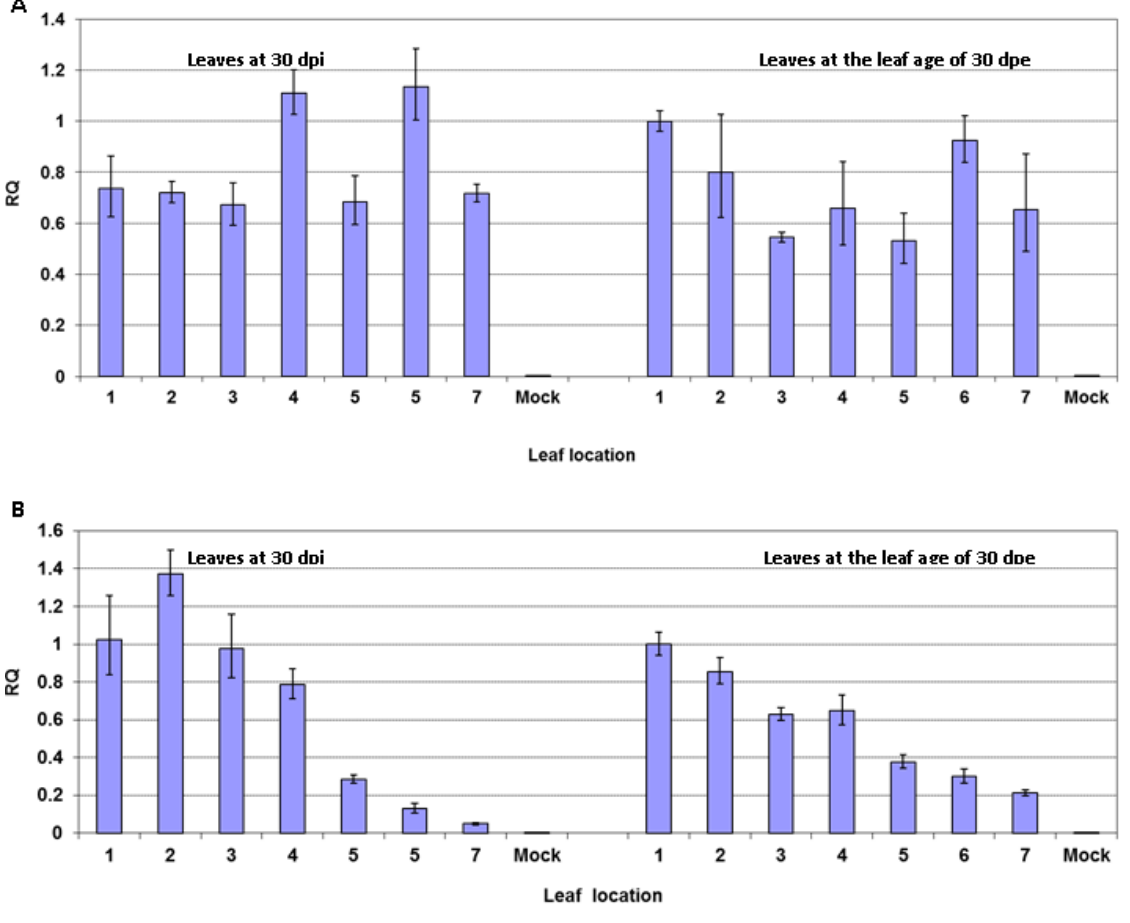
Figure 6. Virus level in leaves emerged after inoculation in potato and tomato plants infected with PVY N:O -Mb58. ( A ) Leaves of potato (cv. “Ranger Russet”) at 30 days post-inoculation (dpi) and at the leaf age of 30 days post-emergence (dpe); ( B ) Leaves of tomato (cv. “Sheyenne”) at 30 dpi and at the leaf age of 30 dpe. The relative virus level (RQ) was obtained by real-time RT-PCR analysis of PVY RNA upon normalization with COX1 mRNA in